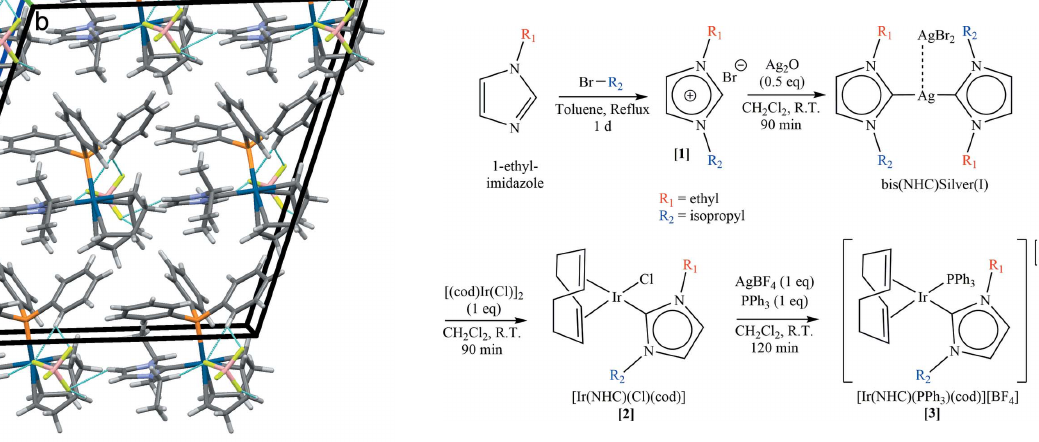
Figure 3 A scheme showing the various steps in the synthesis of the title compound